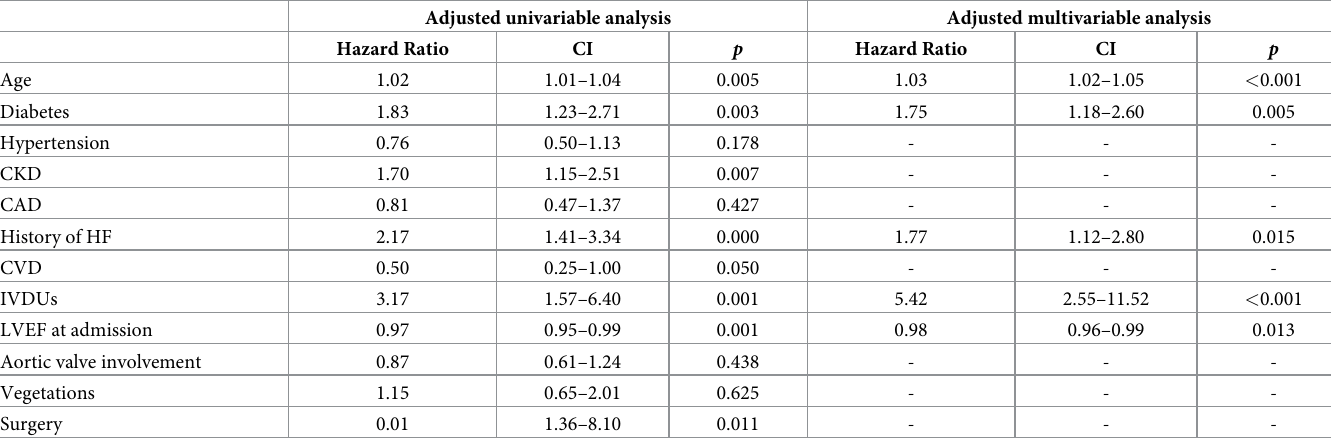
Table 6. Cox regression analysis for overall mortality at long-term